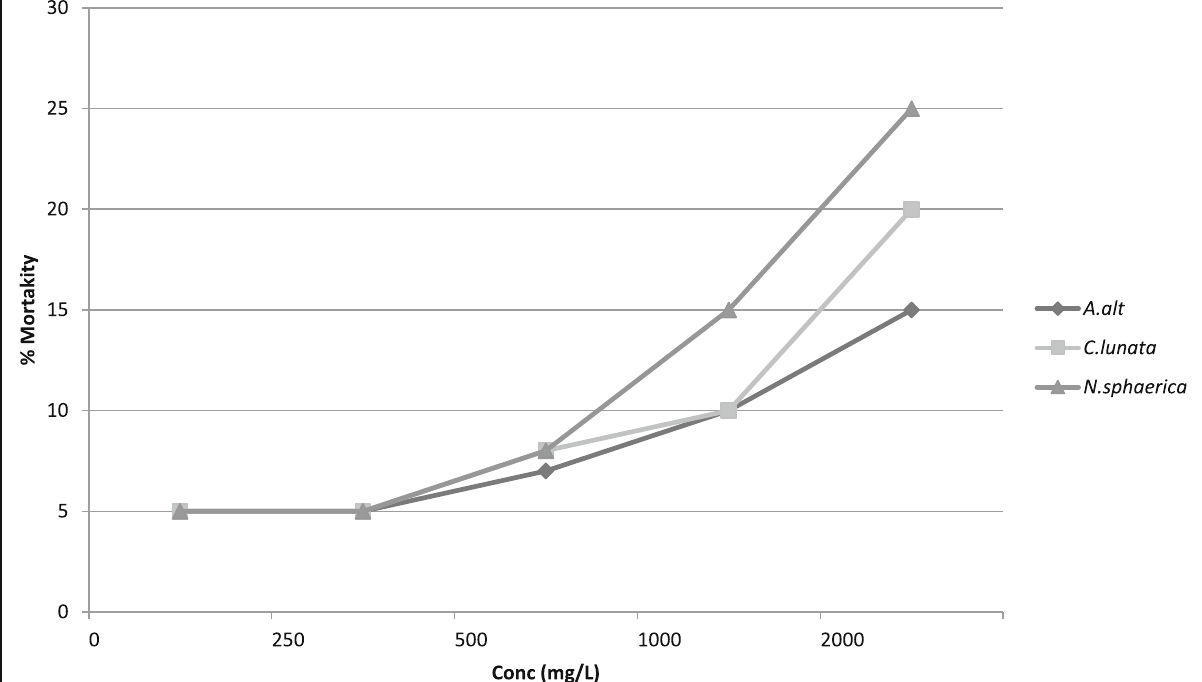
Fig. 5 Mortality percent of the third-instar larvae of Spodoptera littoralis caused by ethyl acetate extracts of the endophytic fungi by residual film after 5